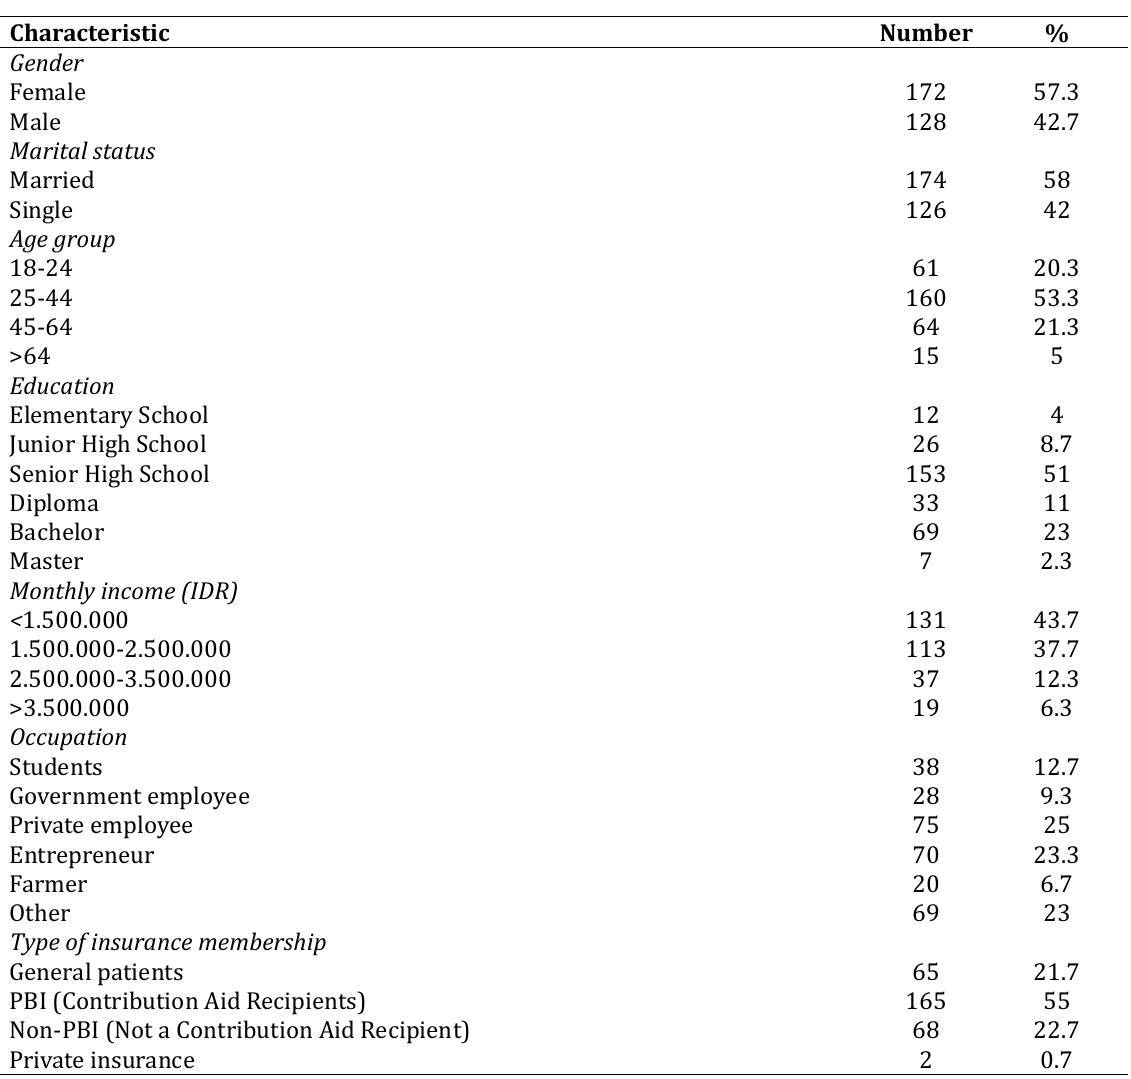
Table I. The Respondents’ Demographic Profile